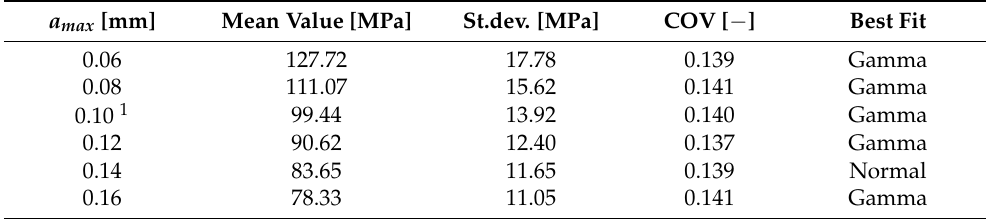
Table 9. Data for a varying maximum flaw depth.